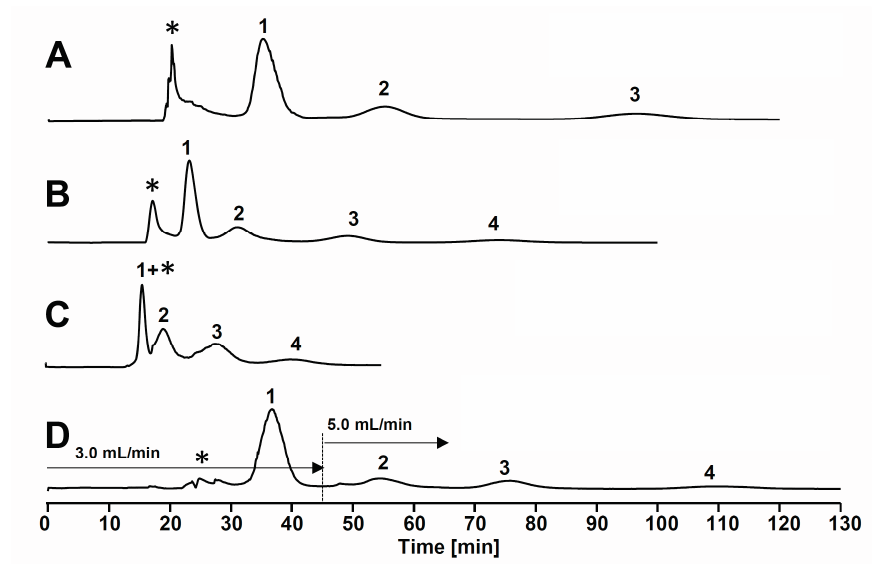
Figure 3. HPCCC separation patterns of the acetone-soluble extract of fermented C. sinensis leaves using n -hexane–ethyl acetate–methanol–water (1:9:1:9, v/v ) system with rotational speed at 1600 rpm. ( A ) flow-rate at 3.0 mL/min; ( B ) flow-rate at 5.0 mL/min; ( C ) flow-rate at 8.0 mL/min; ( D ) gradient flow-rate at 3.0 mL/min in 0–45 min, and 5.0 mL/min